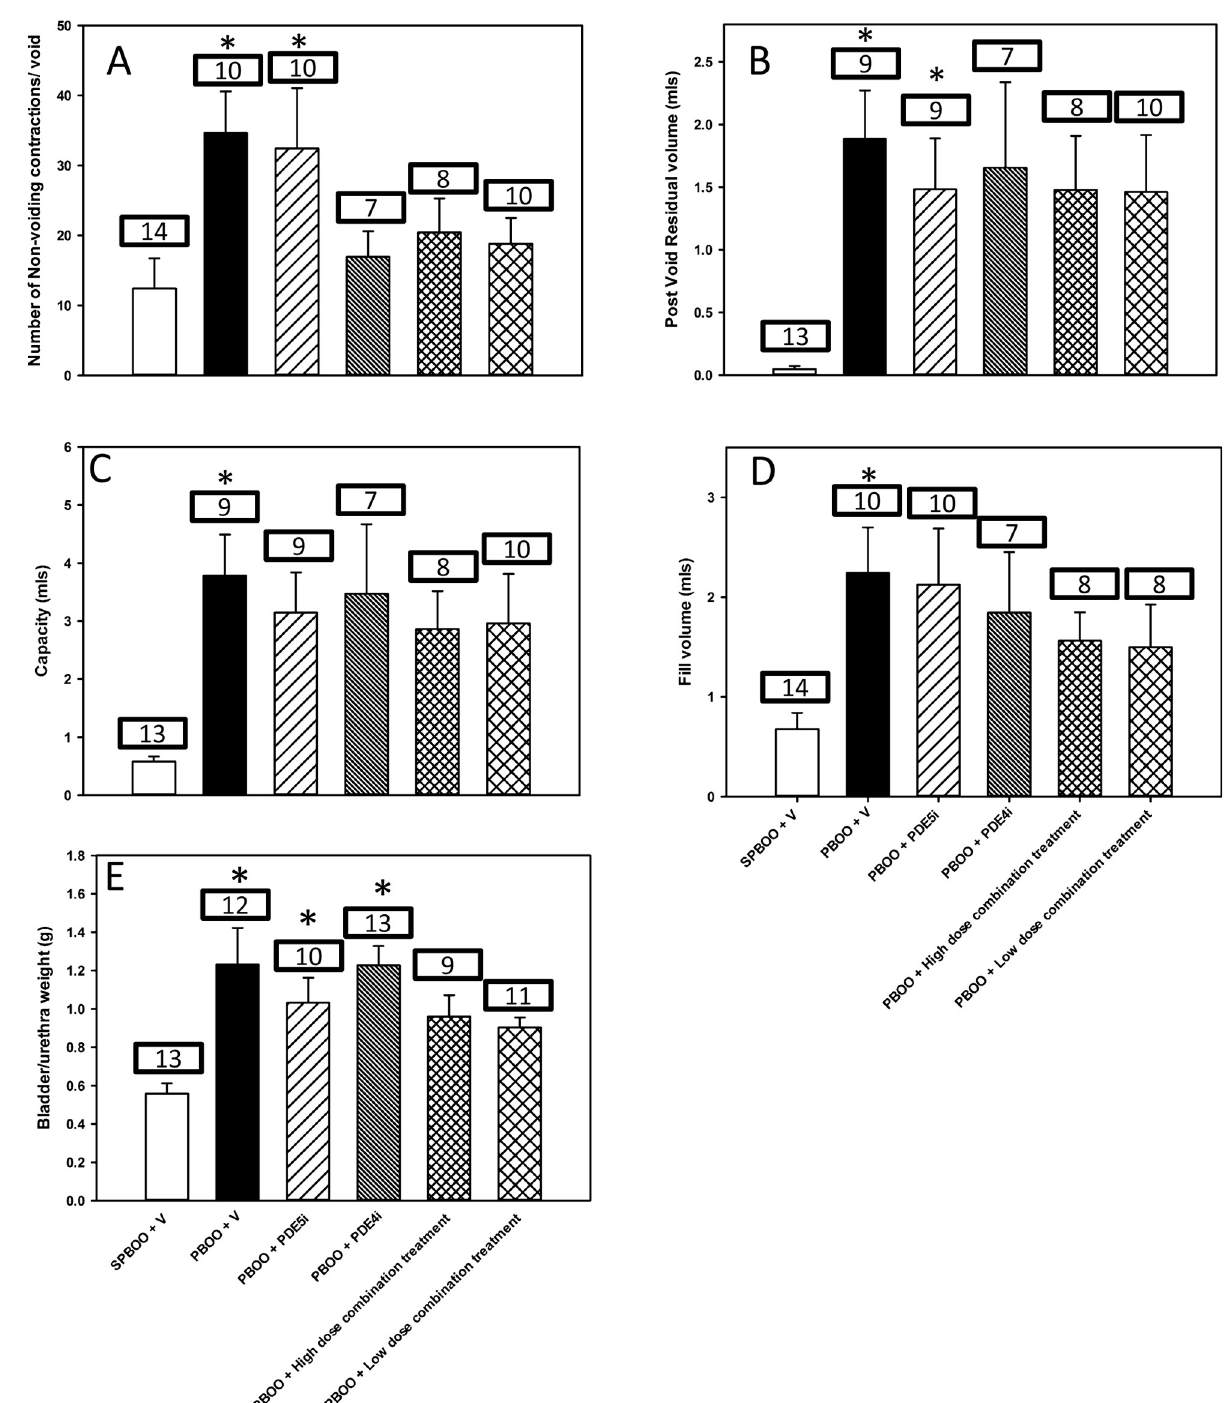
Fig 2. Primary results of conscious cystometry including: Number of non-voiding contractions per void (A), post-void residual volume (B), bladder capacity (C), fill volume (D) and bladder/urethral weights (E) for rats receiving: Sham partial bladder outlet obstruction(PBOO) and vehicle (SPBOO + V), PBOO and vehicle (PBOO + V), PBOO and PDE5i alone (PBOO + PDE5i), PBOO and PDE4i alone (PBOO + PDE4i), PBOO and high dose combination treatment (PBOO + high dose combination treatment) and PBOO and low dose combination treatment (PBOO + low dose combination treatment). Data is presented as mean ± standard error of the mean per group. The number of animals per group per variable are displayed in the box above each bar. � indicates a statistically significant difference compared to SPBOO + V.